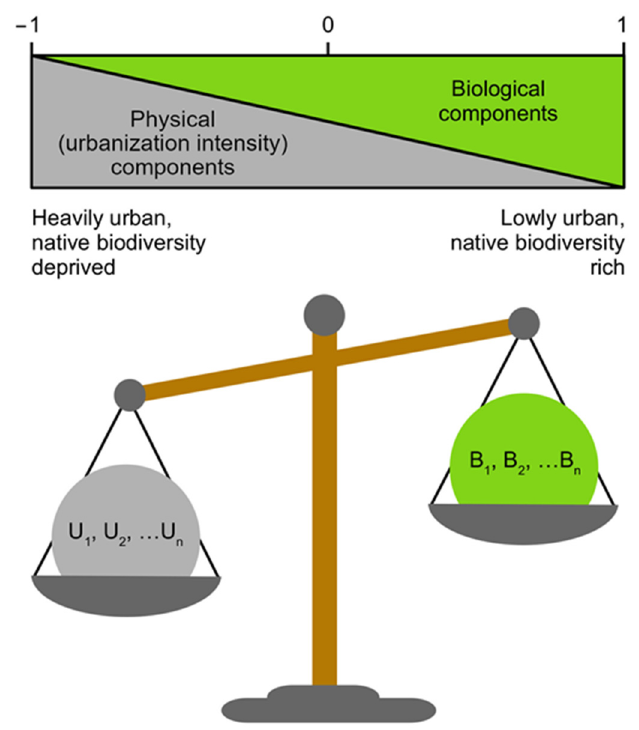
Figure 1. Graphical representation of the rationale behind the Urban Ecosystem Integrity Index (UEII), where U 1 –U n represent the variables that describe the physical (urbanization intensity) component and pull towards the negative values of the UEII and B 1 –B n are the variables describing the biological dimension of the urban continuum, drawing into the positive values of the index, which, in their totality, range from − 1 to 1.